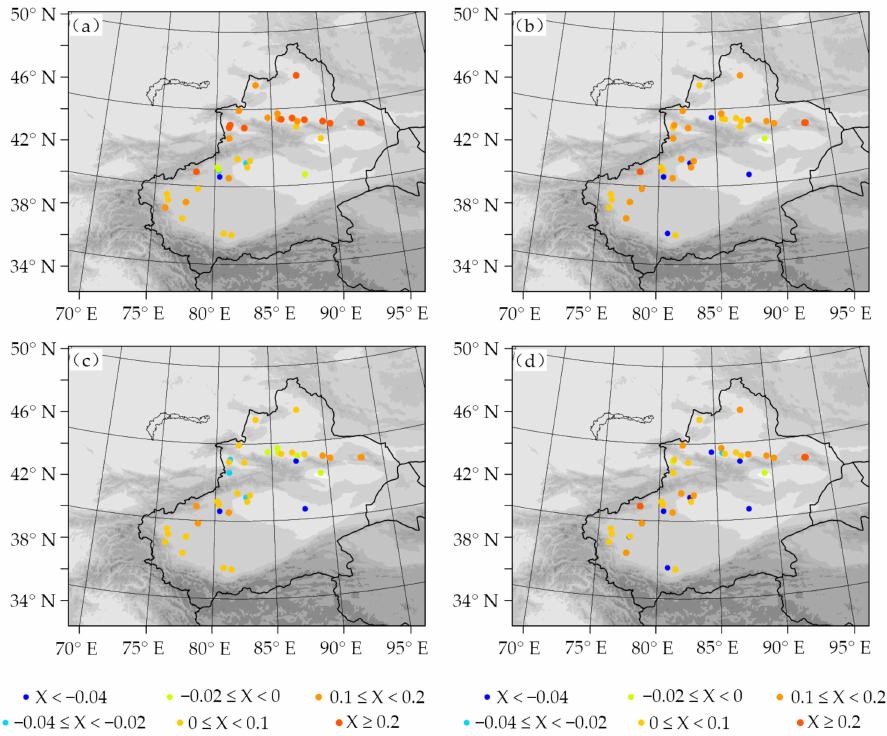
Figure 6. Monthly ME of simulated soil moisture at 5 cm ( a , c ) and 25 cm ( b , d ) thickness in WRF simulations with Noah ( a , b ) and Noah-MP ( c , d ) scheme in January 2017 (unit: m 3 · m − 3